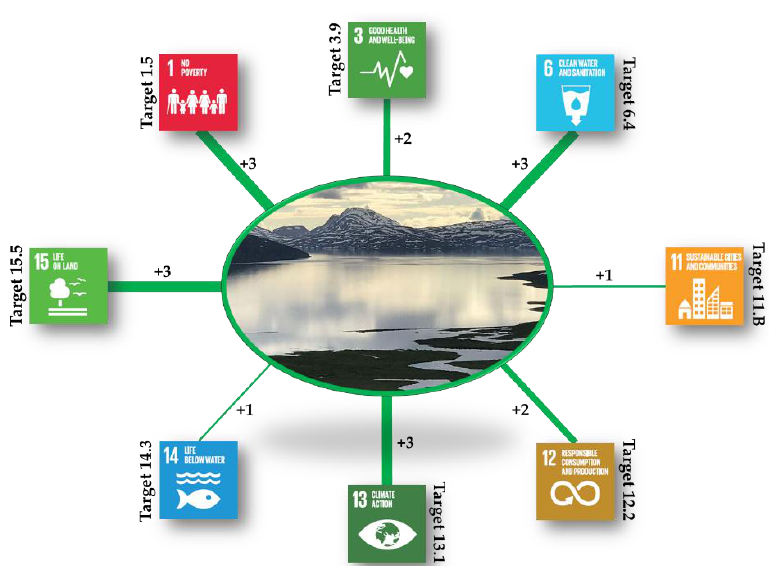
Figure 4. Positive climate regulation interactions identified between United Nations Sustainable Development Goals (SDGs) and Swedish wetland ecosystem services. Photo: https://www.sei.org/projects-and-tools/projects/resilience-and-management-of-arctic-wetlands/.